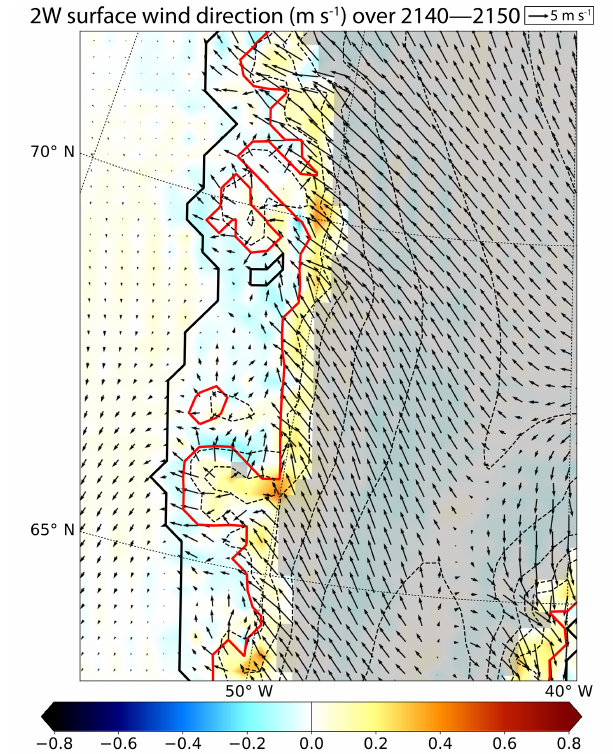
Figure 9. Surface wind speed difference (shaded) between the NF and the 2W experiments for the 2140–2150 mean period. Black ar- rows represent the wind direction in the 2140–2150 mean period of the 2W experiment. The length of the arrows indicates the magni- tude of wind speed. The grey shaded area stands for the extent of the region for which the permanent ice fraction is 100% (no tun- dra). Red solid line indicate the ice sheet extent. The dashed black lines correspond to the 500m surface elevation